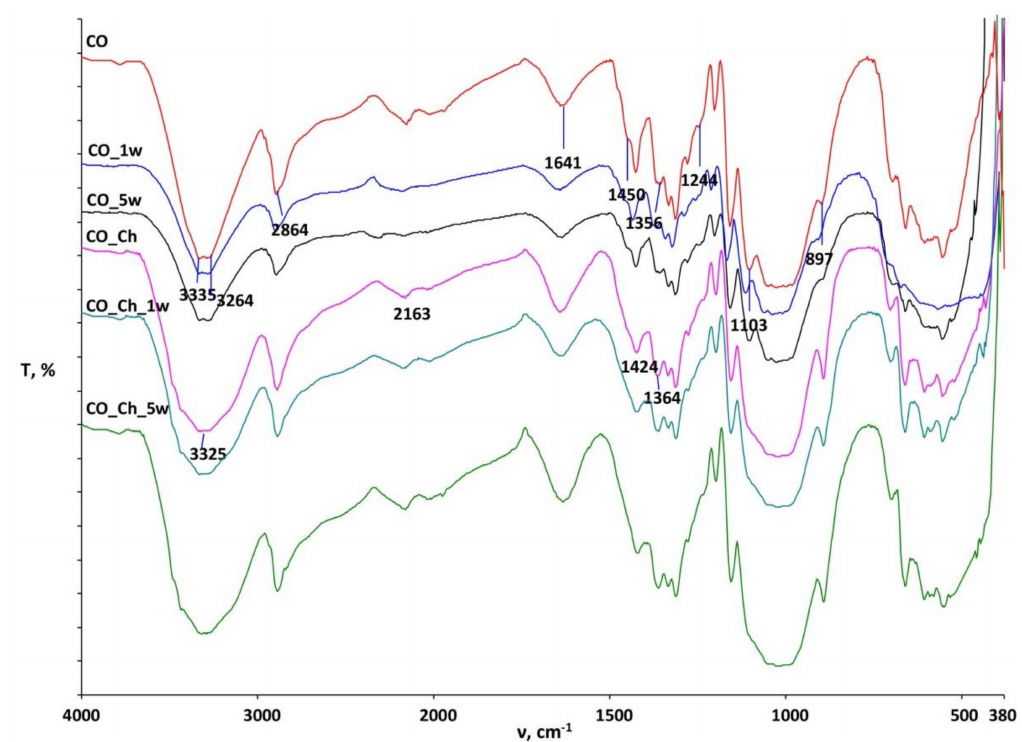
Figure 6. Spectral bands of the standard cotton (CO) fabric and treated samples (CO_Ch) and after the first (CO_1w, CO_Ch_1w) and fifth (CO_5w, CO_Ch_5w) wash cycles.